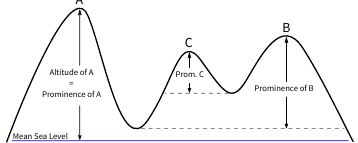
Figure 1: Topographic prominence of a